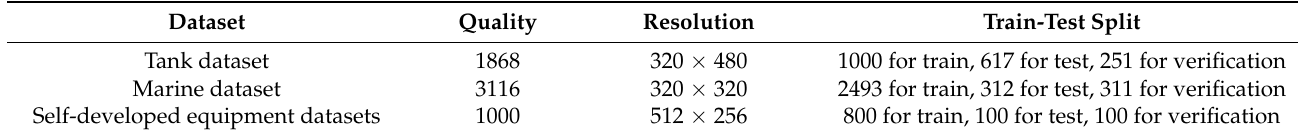
Table 1. Dataset statistics.